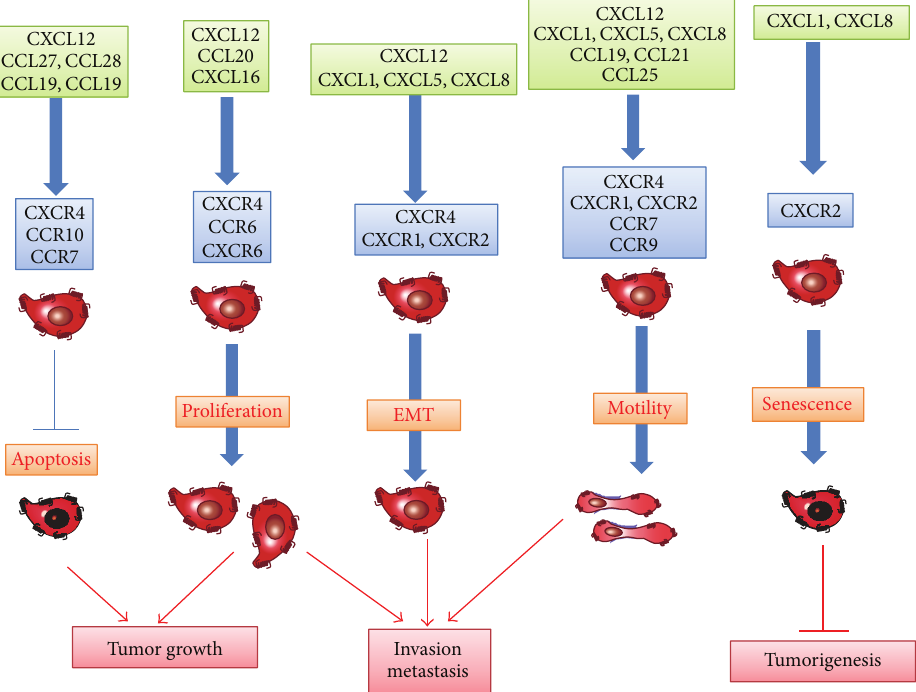
Figure 5: Effects of chemokines on tumor